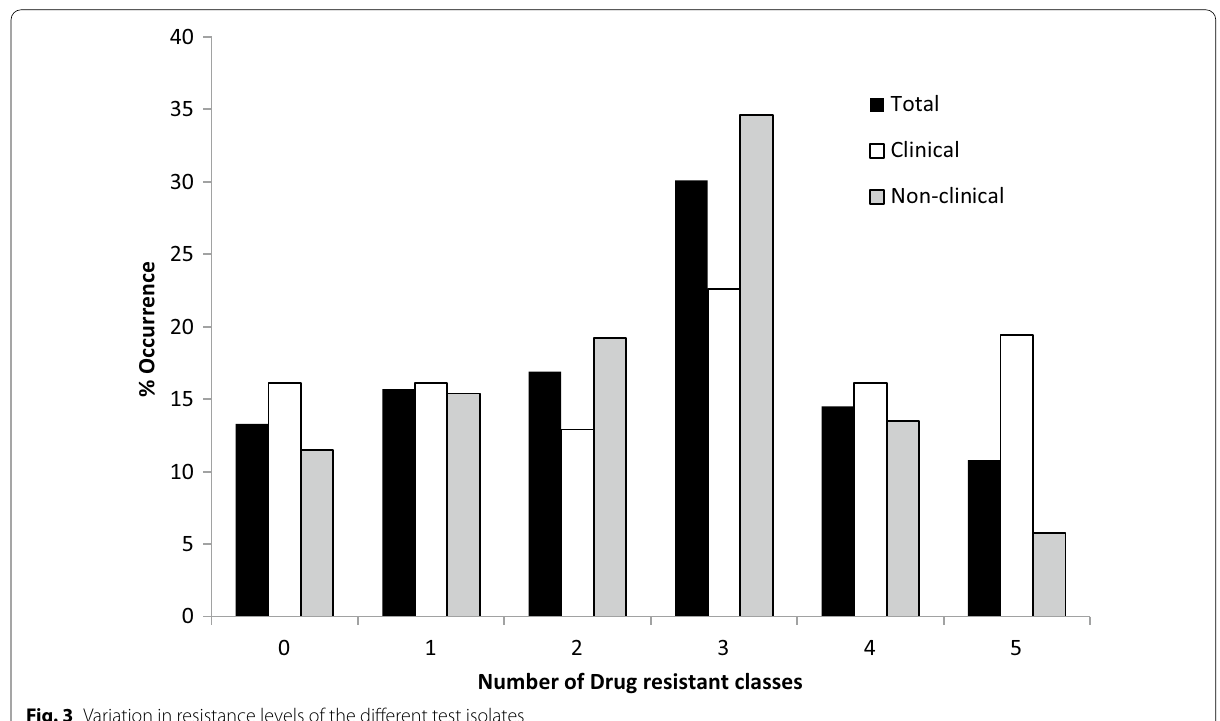
Fig. 3 Variation in resistance levels of the different test isolates